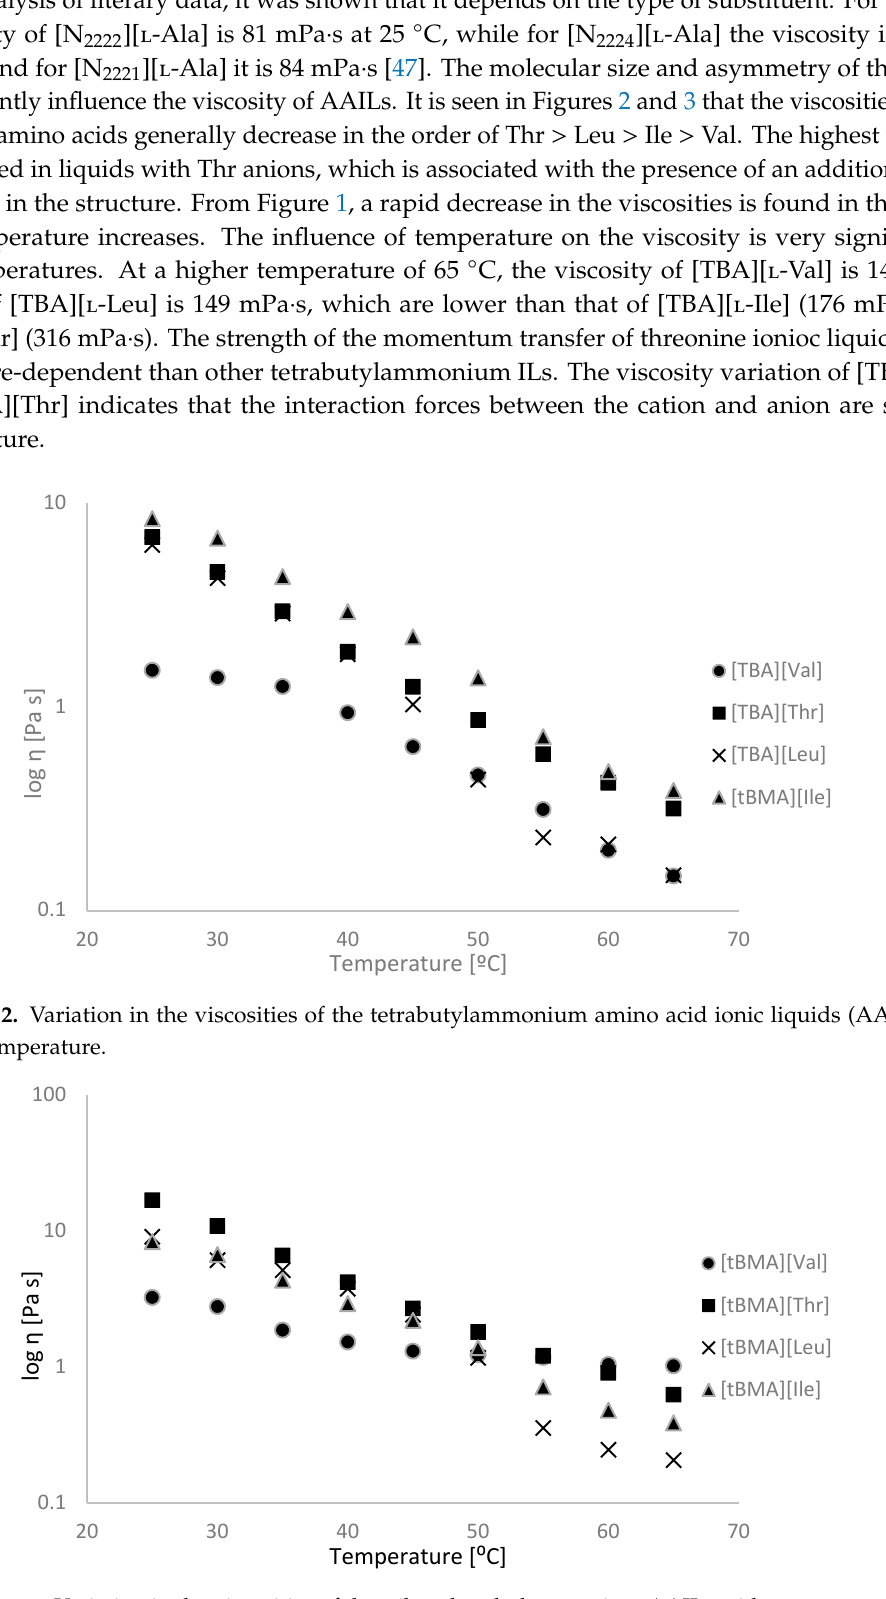
Figure 3. Variation in the viscosities of the tributylmethylammonium AAILs with temperature.